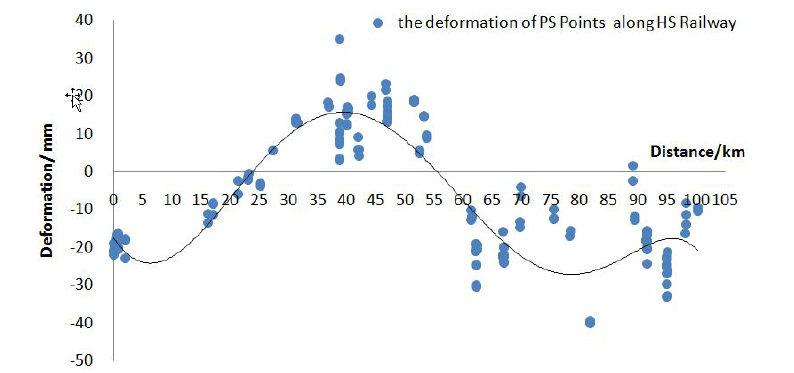
Figure 5. The PS points' subsidence along High-Speed Raliway in